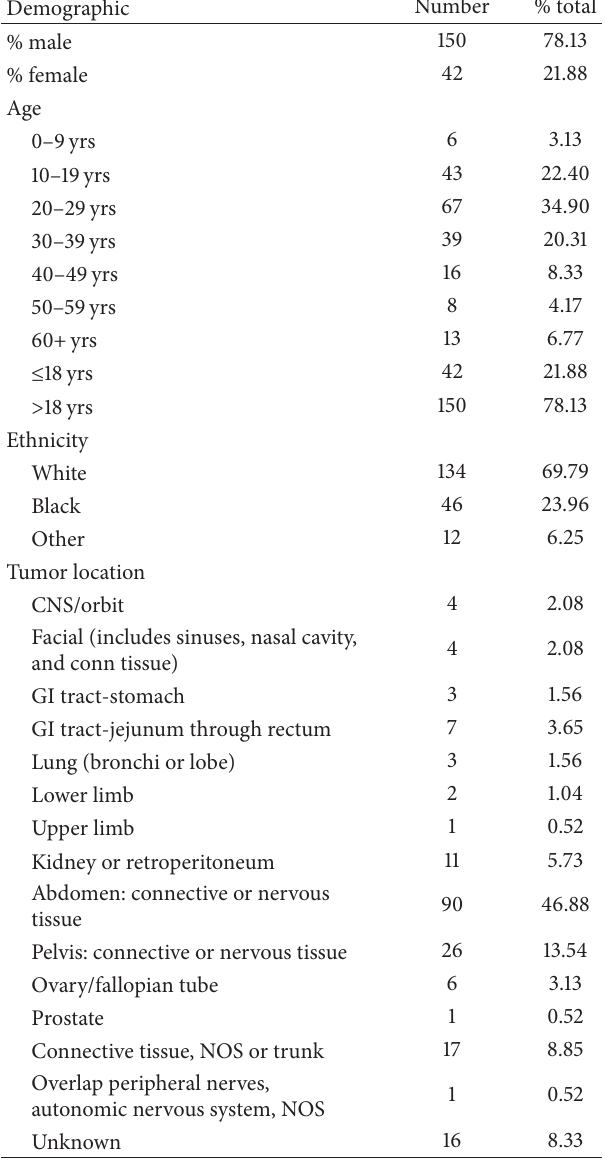
Table 1: Demographics of